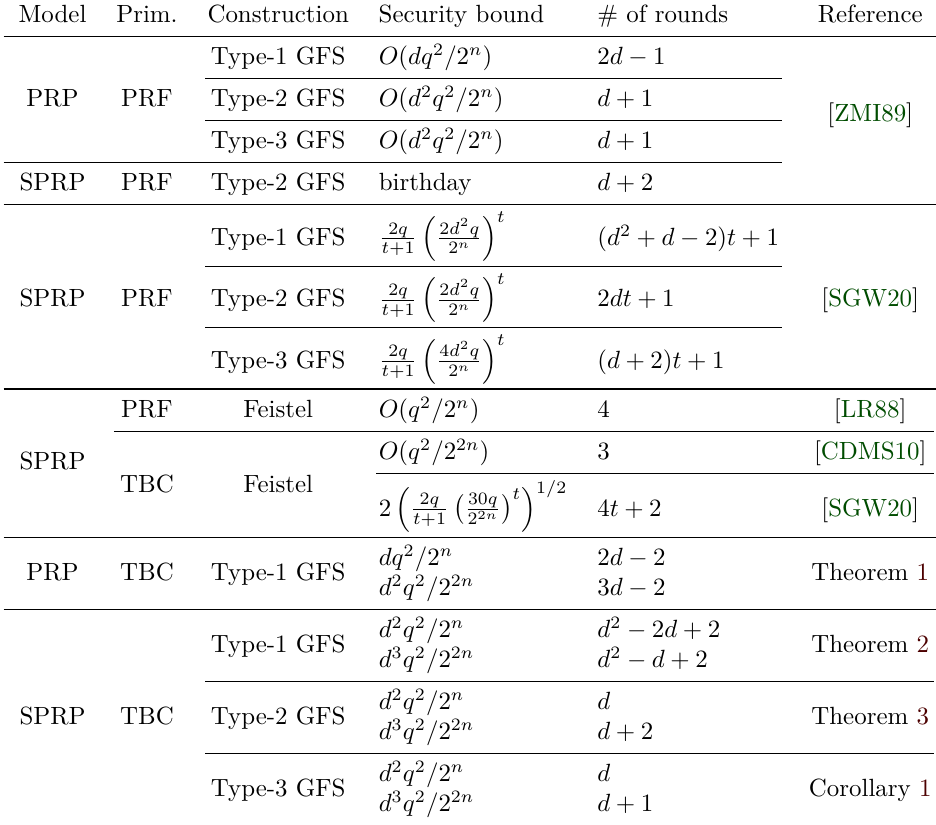
Table 1: Summary of previous results and our results. “Model” shows the attack model and “Prim.” shows the underlying primitive. “Construction” is a block cipher with dn -bit blocks, except for PRF-based Feistel and TBC-based Feistel which are 2 n -bit block ciphers. In the table, q denotes the number of queries, and in the results of [SGW20], t ≥ 1 is a parameter that specifies the number of rounds. Only the leading terms are listed and constants are neglected in our security